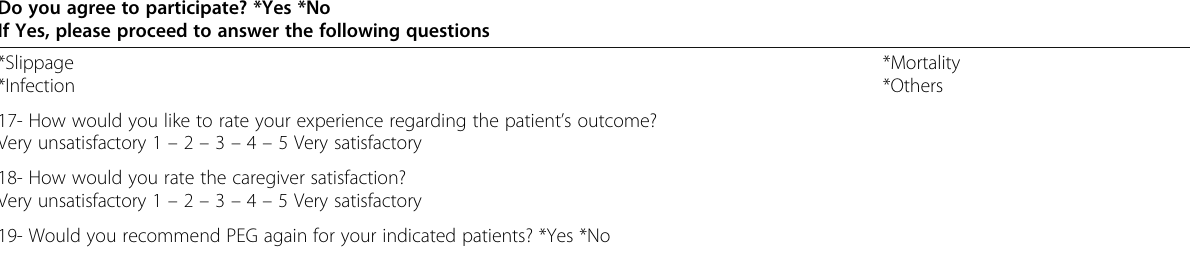
Table 1 Questionnaire regarding neurologists ’ experience regarding PEG (Continued)